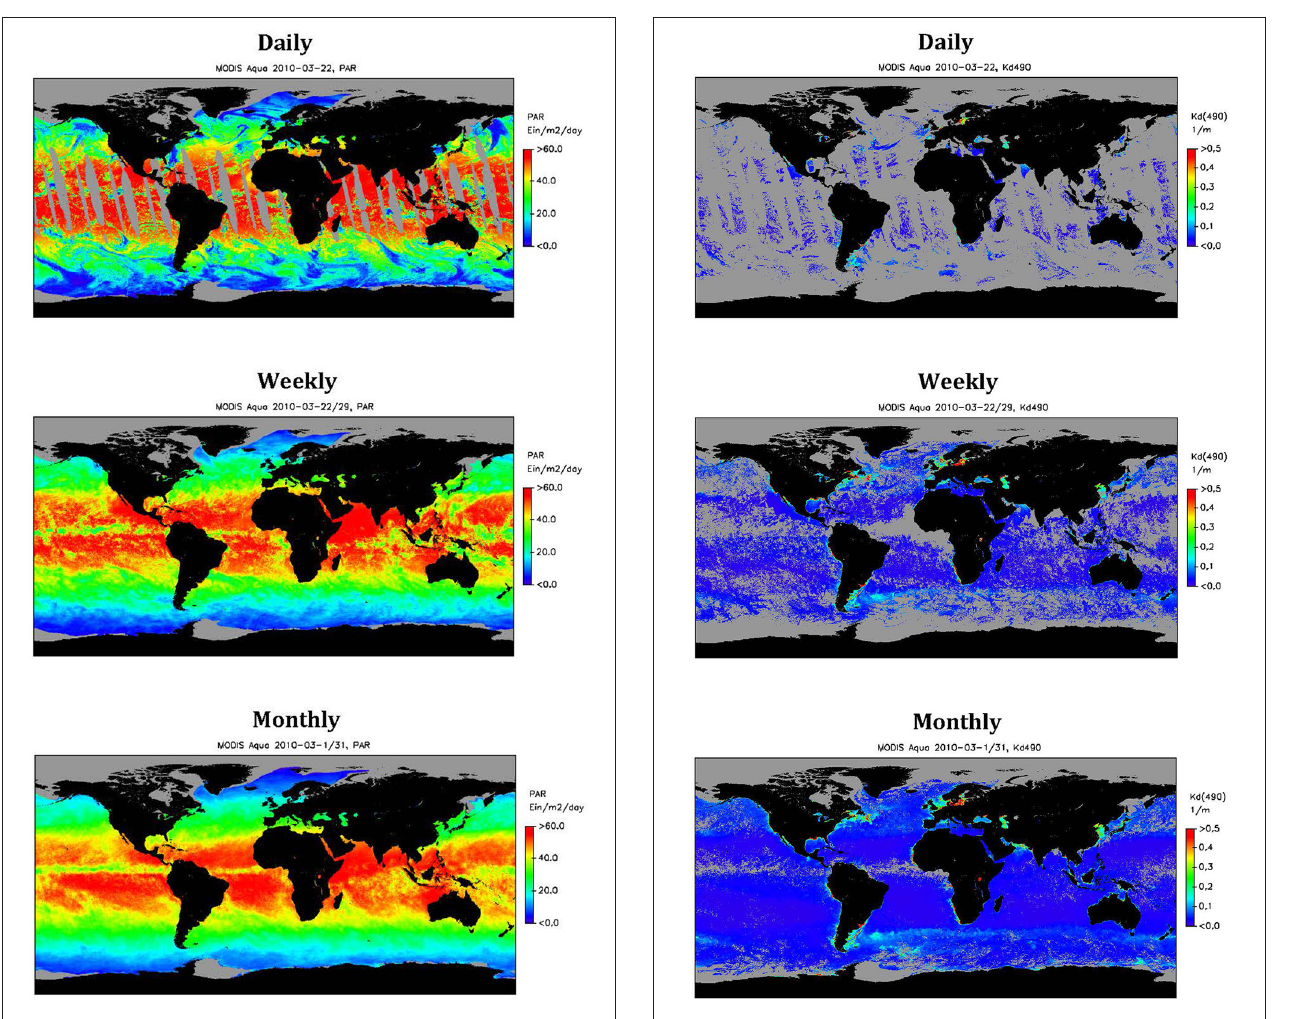
rate are also available. Dates are the same as those of Figure 1